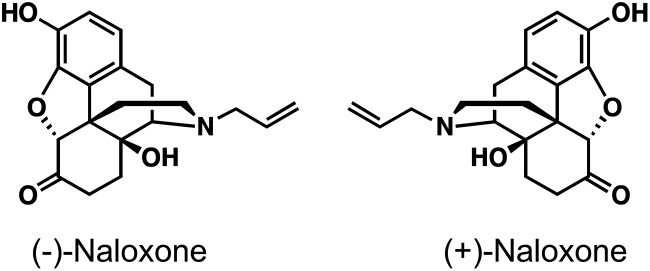
Chemical structure of (–)-naloxone and (+)-naloxone enantiomers.
Ki of (–)-naloxone for antagonizing opioid receptors is in the 1 nM range, whereas (+)-naloxone has a very low affinity for opioid receptors, with a Ki of 10,000 nM (Iijima et al., 1978).